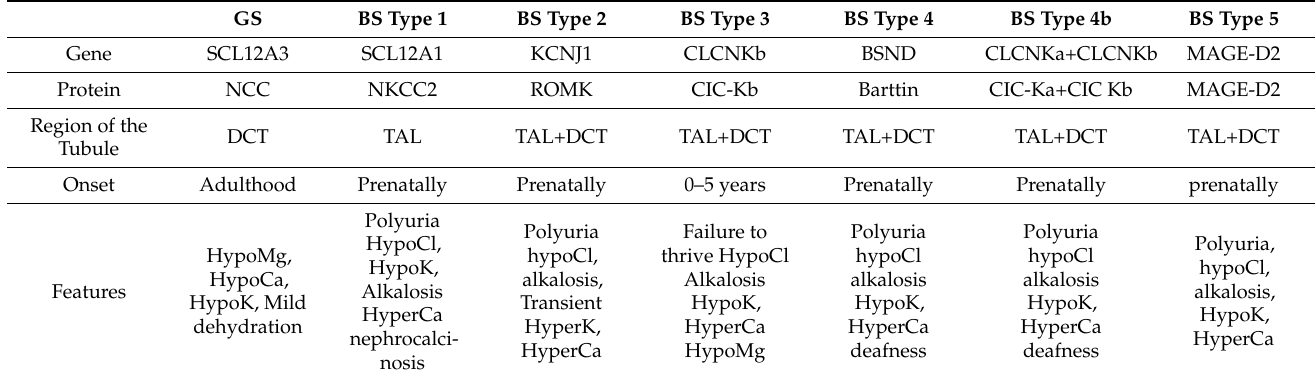
Table 1. Description of mutations in GS and BS and their relative sequelae